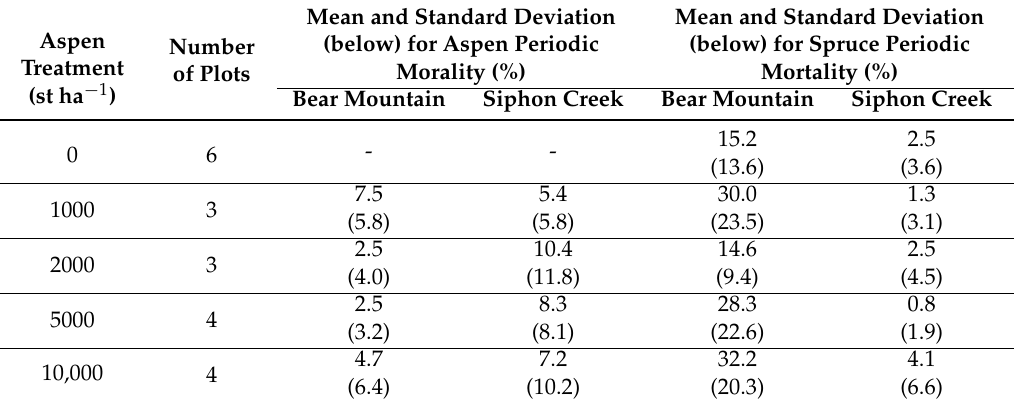
Table 1. Mortality for aspen and spruce over the measurement period (1993 to